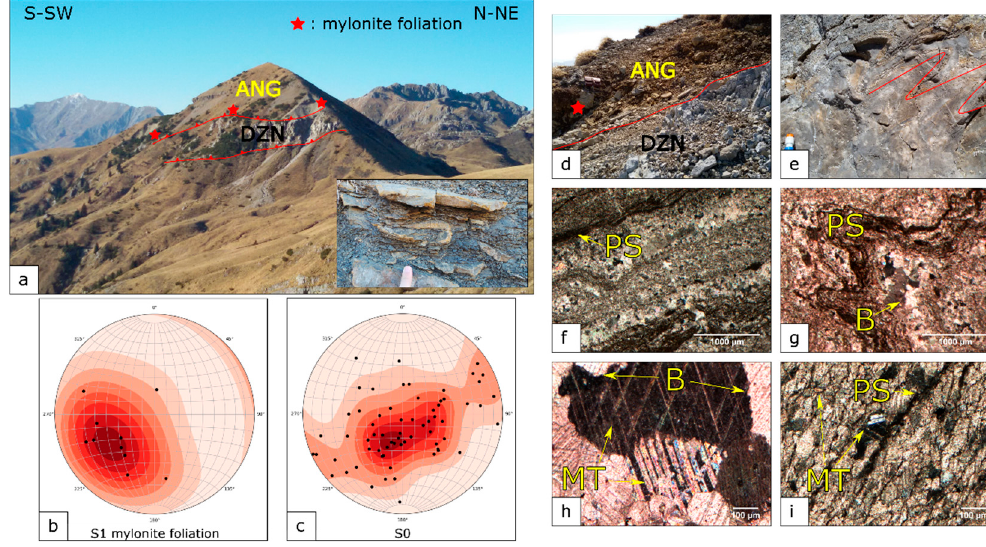
Figure 3. Meso- and microstructural features of the Southalpine Monte Sodadura carbonate mylonites. ( a ) NNE–SSW section of the Monte Sodadura showing the mylonitic horizons developed within the Calcare di Angolo Formation (ANG) where samples were collected. In the inset, an example of the plastic deformation that occurred within the carbonatic shales (ARS—Argillite di Riva di Solto Formation) underlying the tectonic contact with the Dolomie Zonate Formation (DZN) is shown. ( b ) Stereographic projections of the S1 mylonite foliation and ( c ) the S0 stratigraphic surfaces. ( d , e ) Mesoscopic feature of the mylonite horizon showing folds and syn-deformational foliation. ( f – i ) Micro-scale images of the carbonate mylonite displaying different types of deformational microstructures and mechanisms (PS: pressure solution; B: bulging; and MT: mechanical twinning).